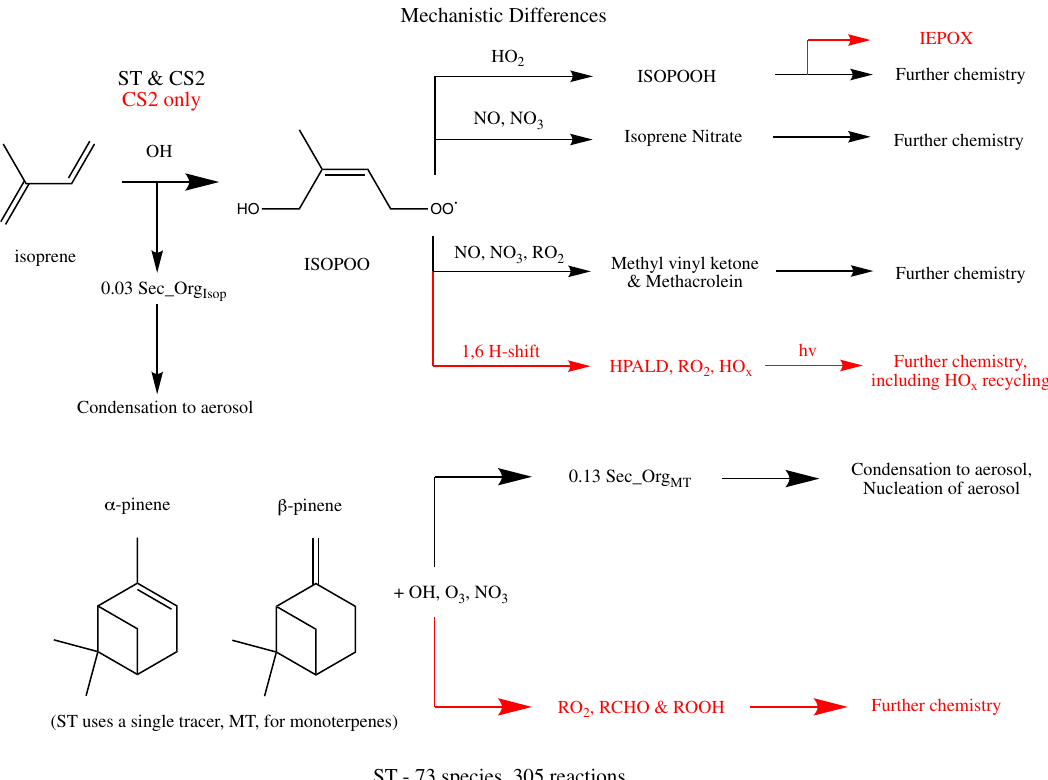
Fig. 1 | Mechanistic differences between Strat-Trop (ST) and CRI-Strat 2 (CS2) for the key processes of isoprene oxidation by OH and oxidation of mono- terpenes (represented by α -pinene and β -pinene in CS2). Processes in black are